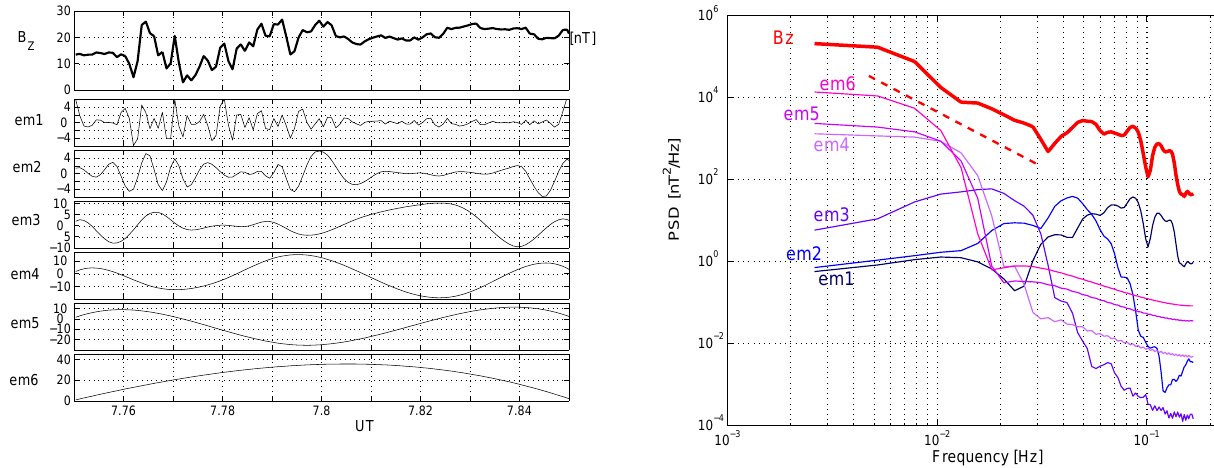
Fig. 2. Top subplot: magnetic field B Z component; Bottom sub- plots: empirical modes; emi s, for i = 1 , 2 ,... 6. Fig. 3. Power spectral density for magnetic field (red thick line) and empirical modes; the dashed red line shows the scaling region over the inverse cascade frequency